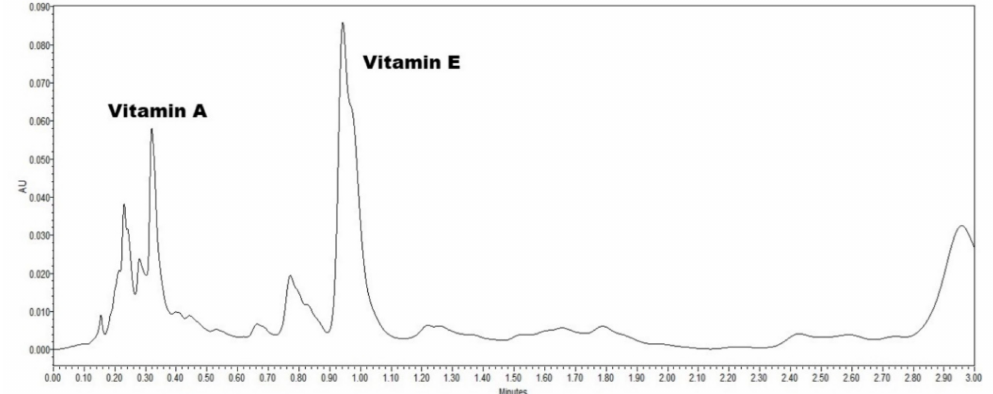
Figure A4. Chromatogram of leaves extracts obtained from habanero pepper plants grown in black soil.